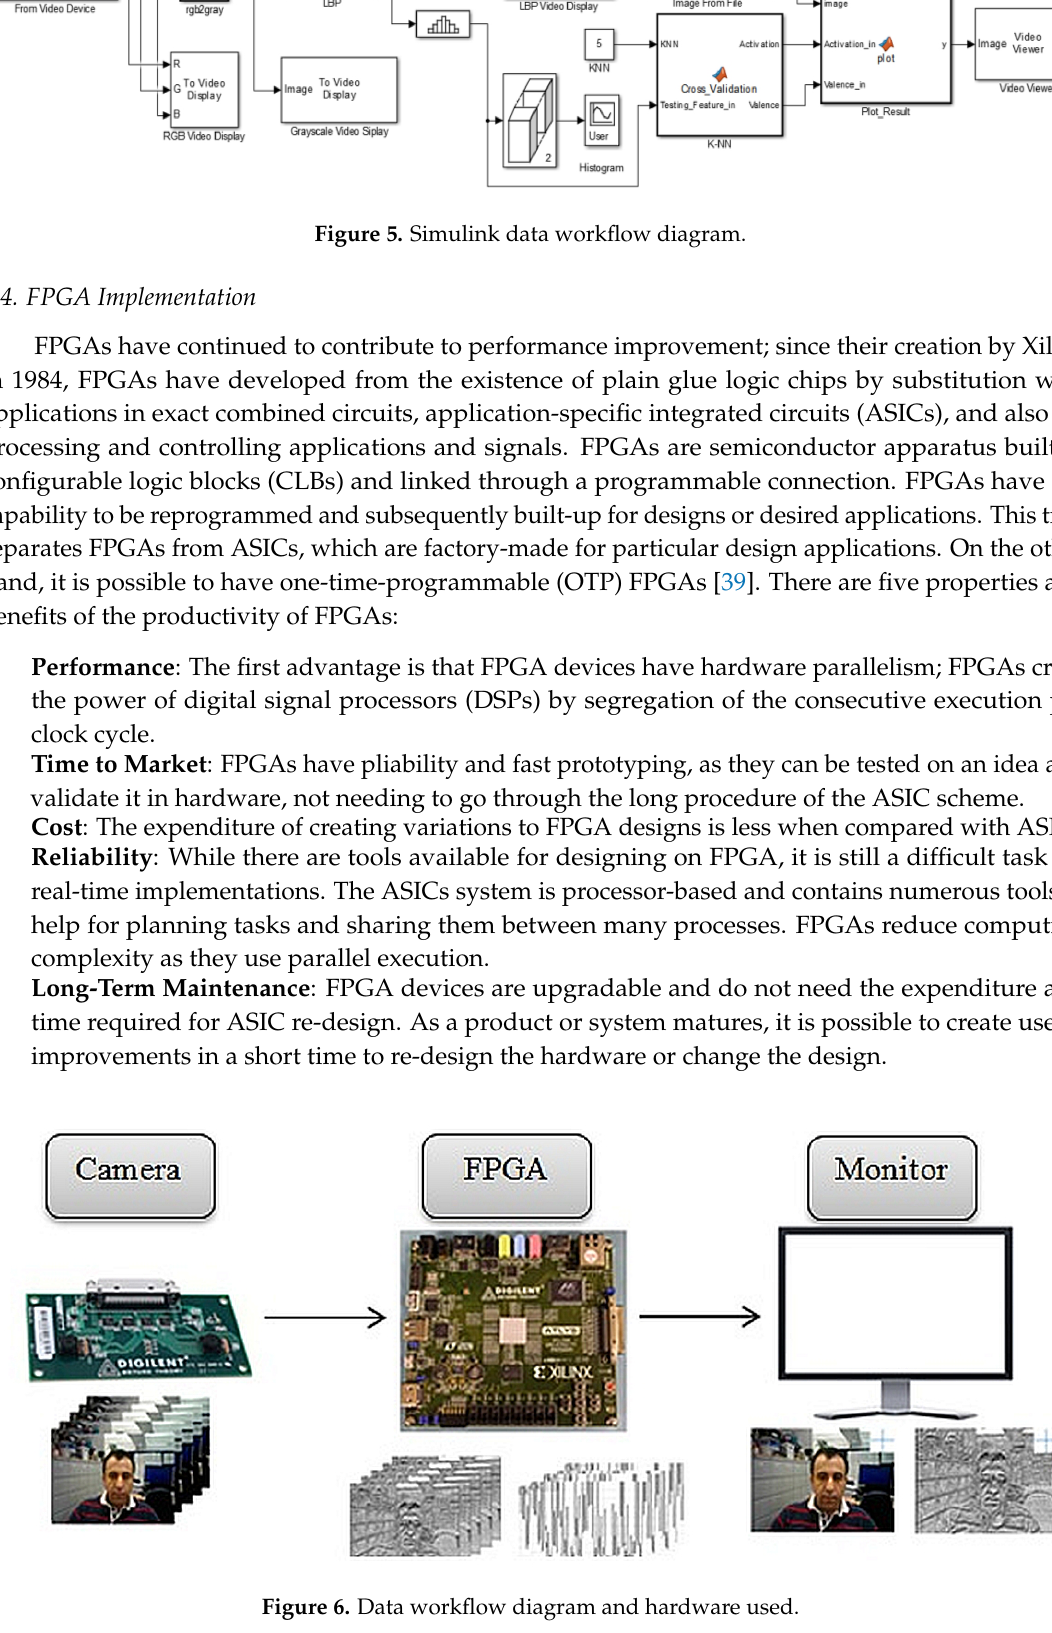
Figure 6. Data workflow diagram and hardware